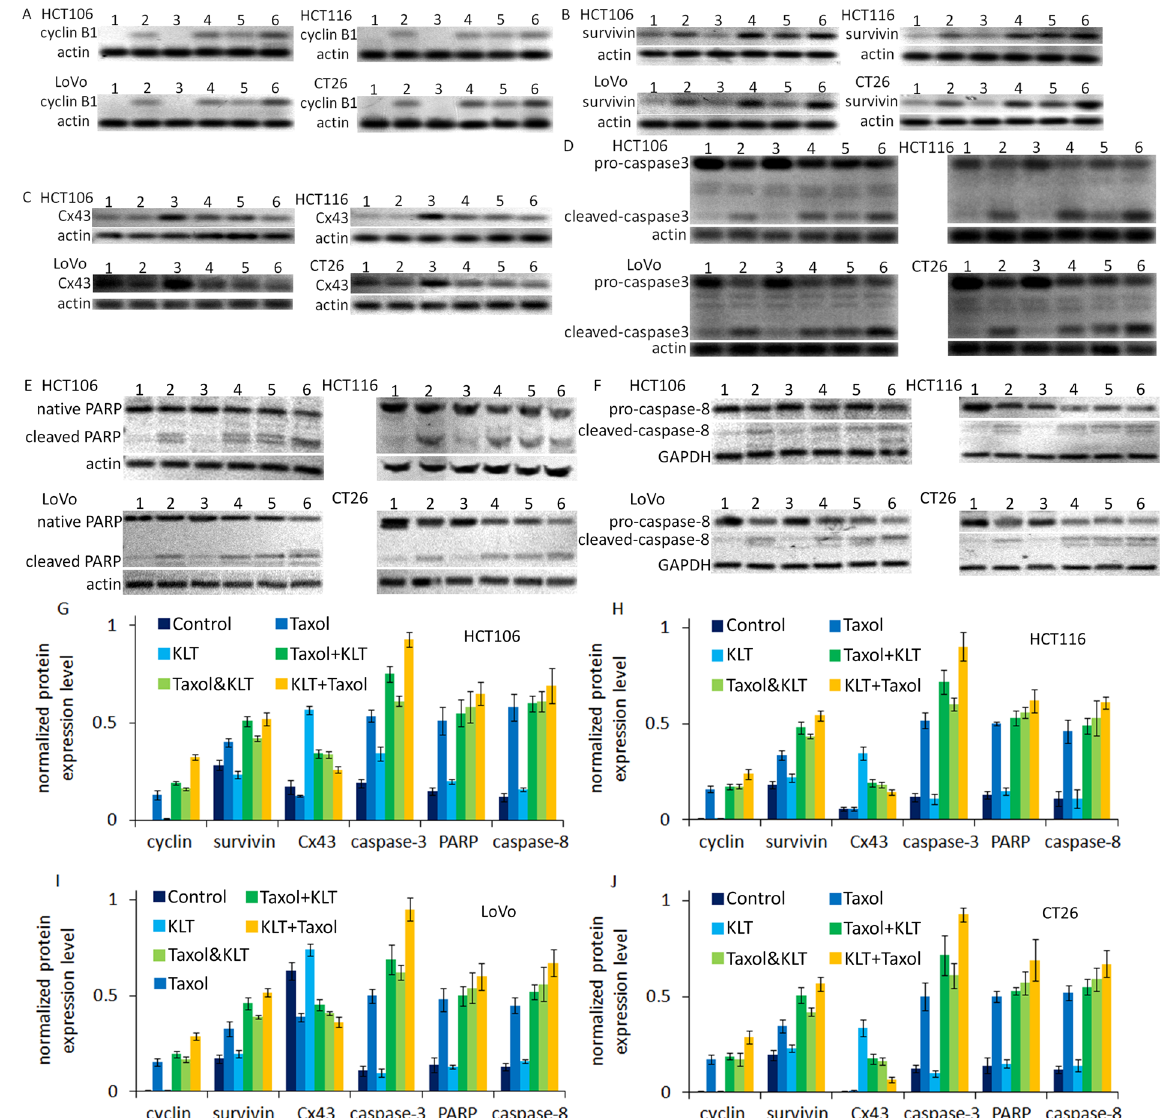
1: control; 2: Taxol; 3: KLT; 4: Taxol + KLT; 5: Taxol&KLT; and 6: KLT + Taxol. ( A ) Cyclin B1 expression in the four cell lines; ( B ) Survivin expression in the four cell lines; ( C ) Cx43 expression in the four cell lines; ( D ) Cleavage of caspase-3 in the four cell lines; ( E ) Cleavage of PARP in the four cell lines; ( F ) Cleavage of caspase-8 in the four cell lines; ( G–J ) The densitometric analysis bar diagram of the results. Columns represent the mean from three independent experiments and bars represent standard deviations. These combinations are defined in “Kanglaite and Taxol treatment”. ( G ) HCT106; ( H ) HCT116; ( I ) LoVo; ( J )